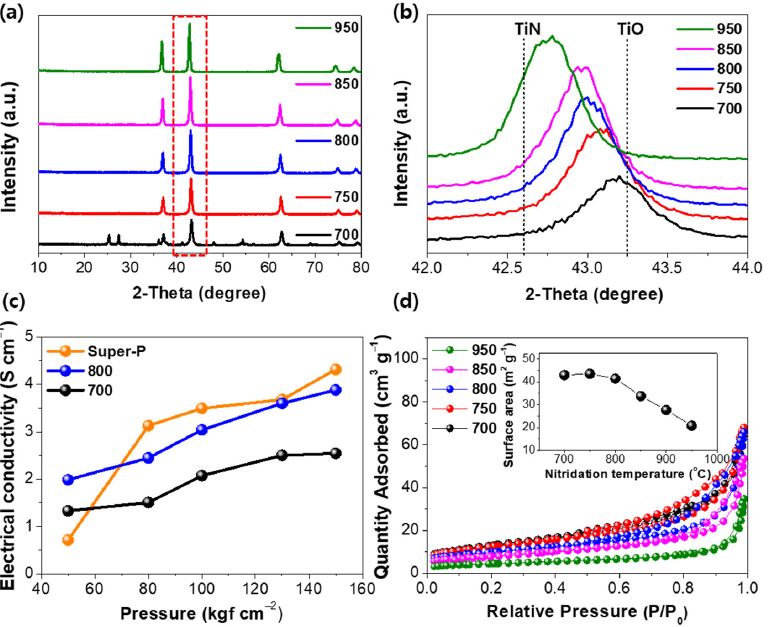
Figure 1. Physicochemical properties of TiON prepared with different nitridation temperatures. ( a ) XRD patterns and ( b ) magnified major peaks at 2-theta 42–44°. ( c ) Electrical conductivity behavior ( a ) XRD patterns and ( b ) magnified major peaks at 2-theta 42–44 ◦ . ( c ) Electrical conductivity behavior